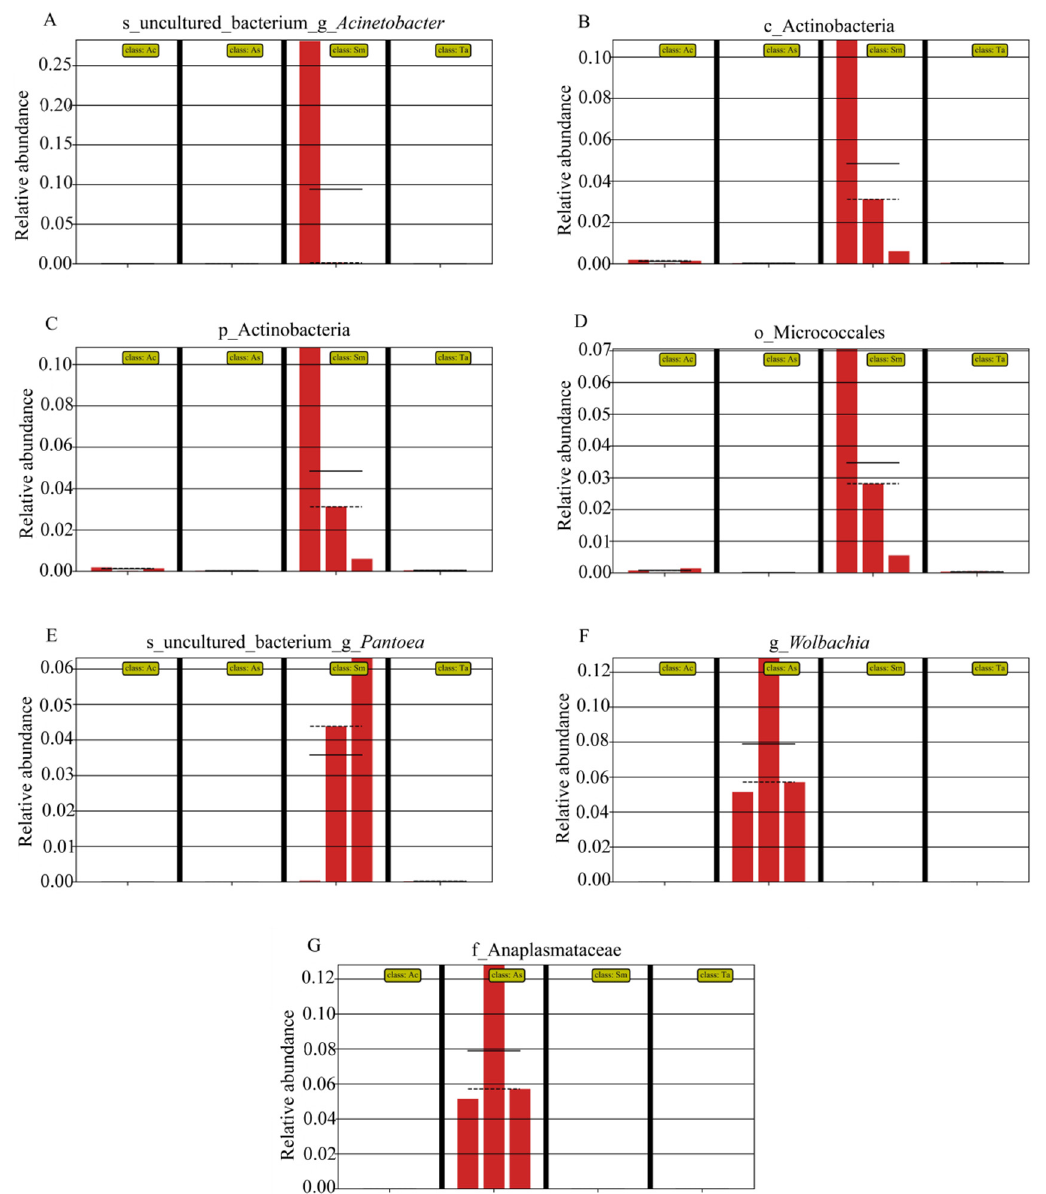
Figure 7. Abundance histogram of bacterial taxa with linear discriminant analysis (LDA) score greater than four in the gut microbiota. Different groups are separated by black bold solid lines. The solid line in the histogram of each group represents the average value of the expression amount of the reorganized sample, and the dotted line represents the median value of the expression amount of the group of samples. ( A ) s_uncultured_bacterium_g_ Acinetobacter . ( B ) c_Actinobacteria. ( C ) p_ Actinobacteria. ( D ) o_Micrococcales. ( E ) s_uncultured_bacterium_g_ Pantoca . ( F ) g_ Wolbachia . ( G ) f_Anaplasmataceae.